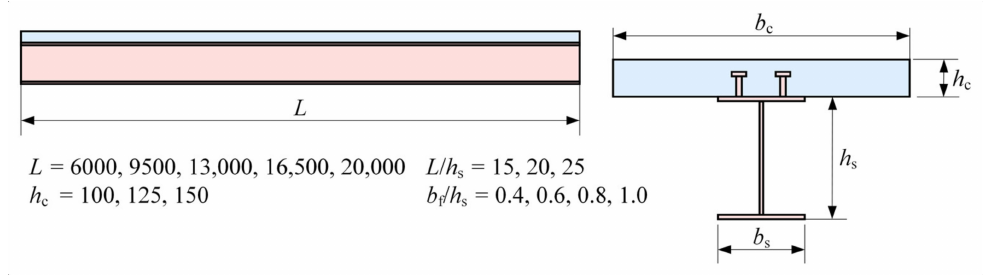
Figure 8. Numerical examples of the composite frame